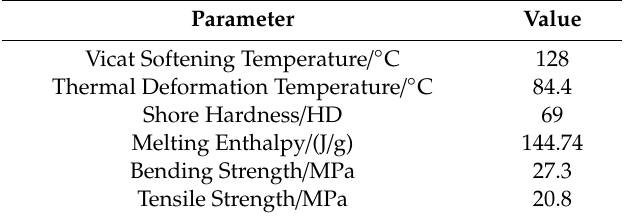
Table 2. Thermal and mechanical properties of pure UHMWPE pipe.